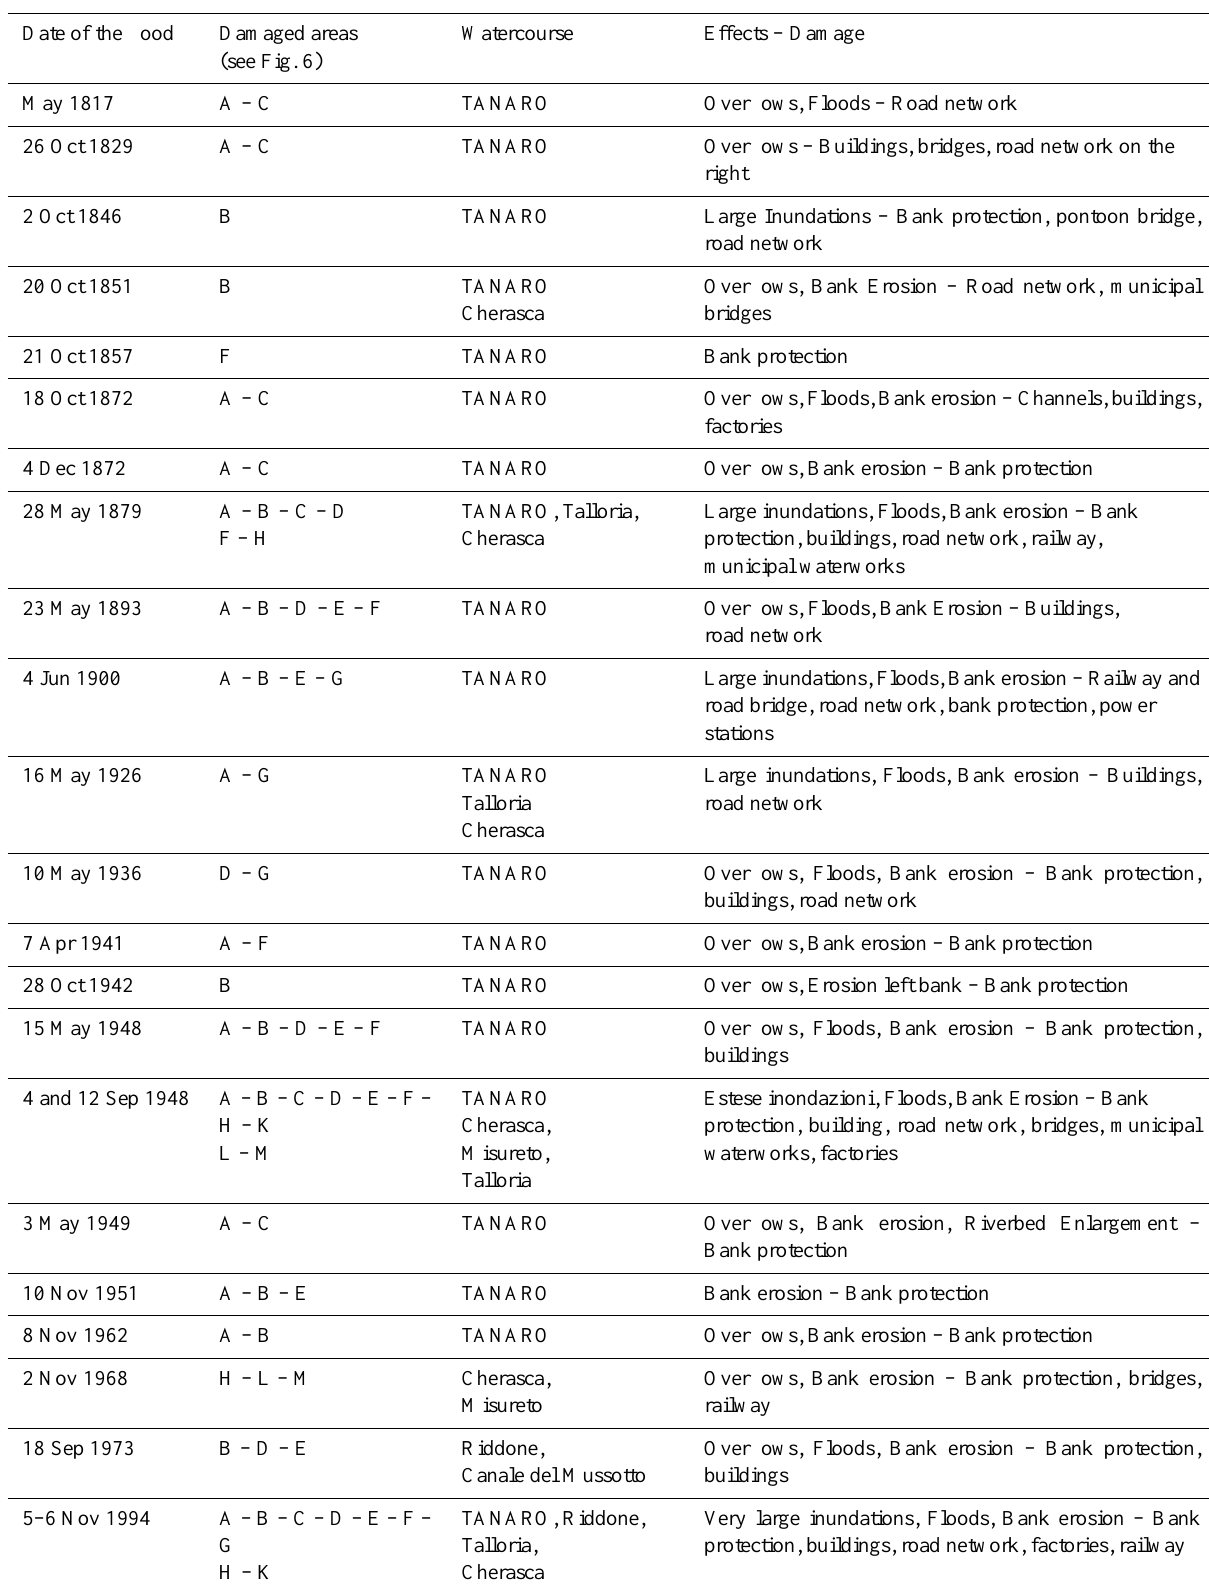
Table 1. Main effects and damage caused by floods of the Tanaro and its tributaries in different areas of Alba during the period 1801–2000. Date of the